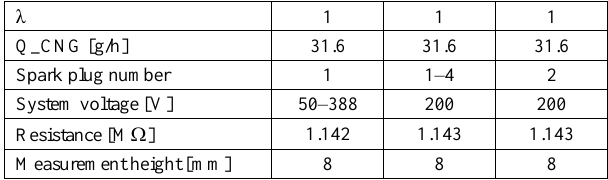
Table 1. Parameters of the burner and the ionization sensor